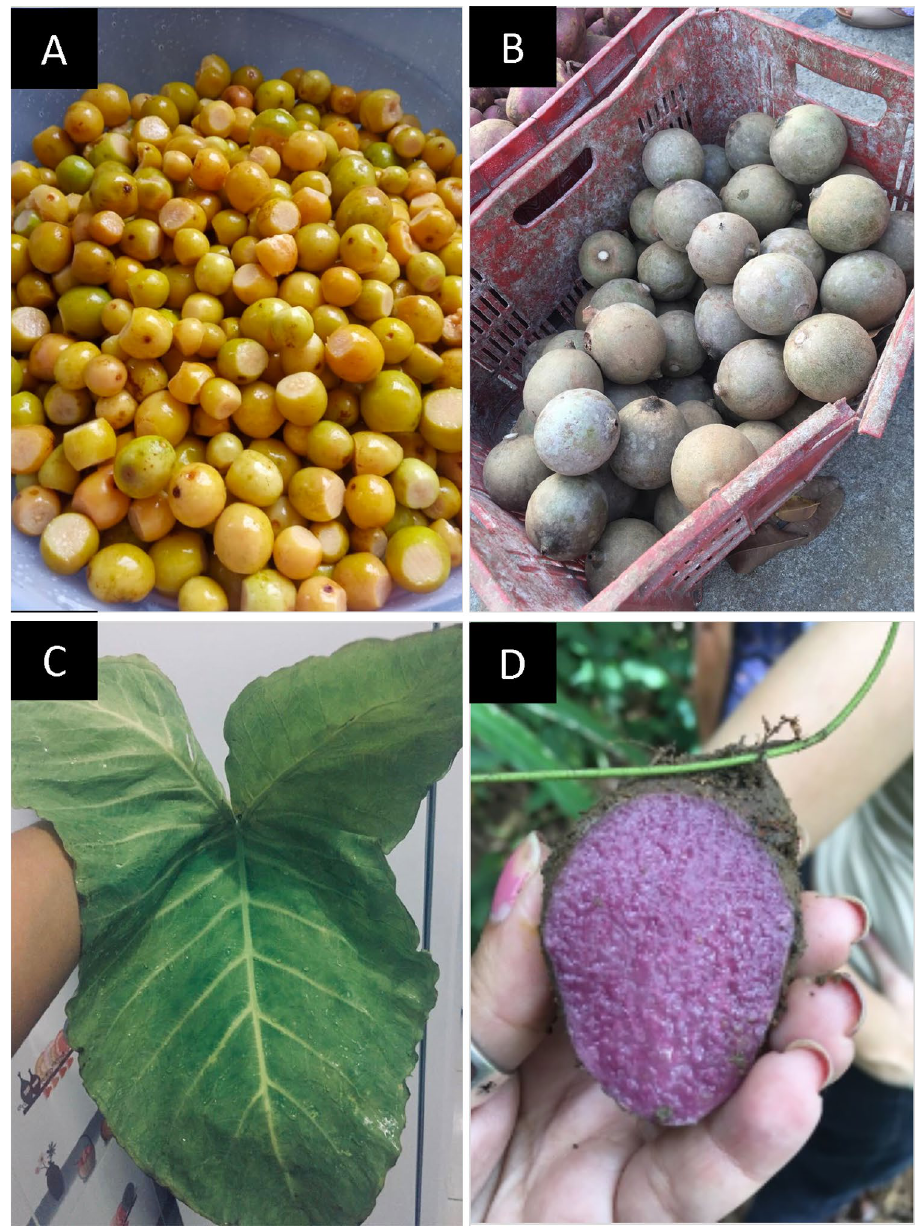
Figure 3. Wild food plants with greater potential for popularization, considering the average of the attributes accessed according to the perception of the residents of the rural settlement Dom Helder Câmara, in the municipality of Murici, state of Alagoas, northeastern Brazil. ( A ) Psidium guineense Sw.; ( B ) American genipa L.; ( C ) Xanthosoma sagittifolium (L.) Schott, and ( D ) Dioscorea trifida